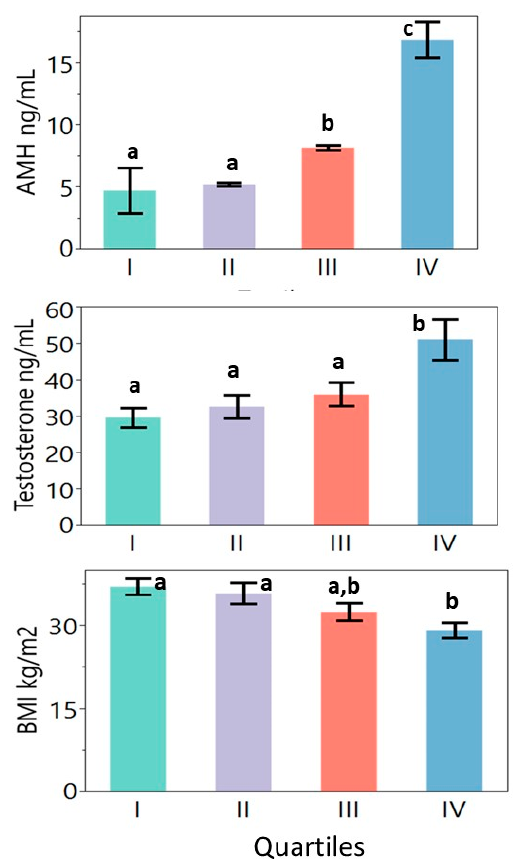
Figure 1. Differences in anti-Mullerian hormone, total testosterone, and body mass index values between quartiles. Continuous variables were evaluated using a one-way ANOVA followed by Tukey’s multiple comparison tests where relevant. Note: a, b, and c notations indicate significant differences among the quartiles at p < 0.05 (quartiles marked with the same letter do not differ significantly from each other).